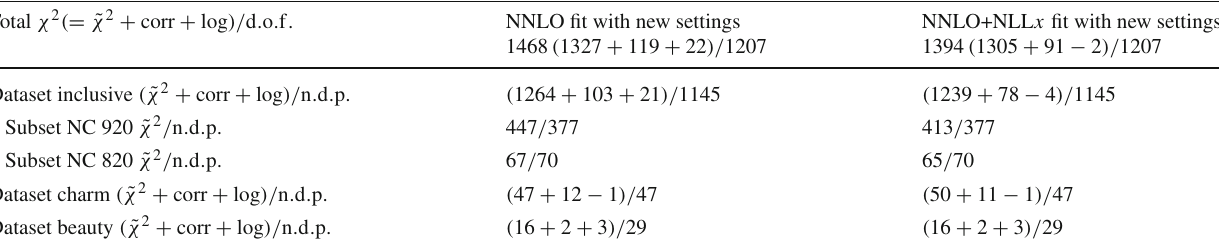
Table 2 Total χ 2 per d.o.f. and some of the partial ˜ χ 2 ’s per number of shown are the contributions to the χ 2 from the correlated shifts and the data points (n.d.p.) for the PDF fits to HERA inclusive and heavy-quark log terms data with and without ln ( 1 / x ) resummation with the new settings. Also Total χ 2 ( = ˜ χ 2 + corr + log )/ d . o . f . NNLO fit with new settings NNLO+NLL x fit with new settings 1468 ( 1327 + 119 + 22 )/ 1207 1394 ( 1305 + 91 − 2 )/ 1207 Dataset inclusive ( ˜ χ 2 + corr + log )/ n . d . p . ( 1264 + 103 + 21 )/ 1145 ( 1239 + 78 − 4 )/ 1145 Subset NC 920 ˜ χ 2 / n . d . p . 447 / 377 413 / 377 Subset NC 820 ˜ χ 2 / n . d . p . 67 / 70 65 / 70 Dataset charm ( ˜ χ 2 + corr + log )/ n . d . p . ( 47 + 12 − 1 )/ 47 ( 50 + 11 − 1 )/ 47 Dataset beauty ( ˜ χ 2 + corr + log )/ n . d . p . ( 16 + 2 + 3 )/ 29 ( 16 + 2 + 3 )/